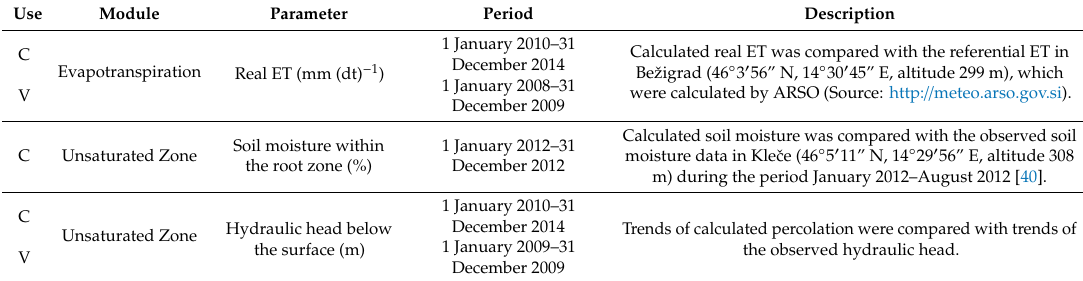
Table 3. Parameters used for the calibration (C) and validation (V) of the WaSiM model during di ff erent